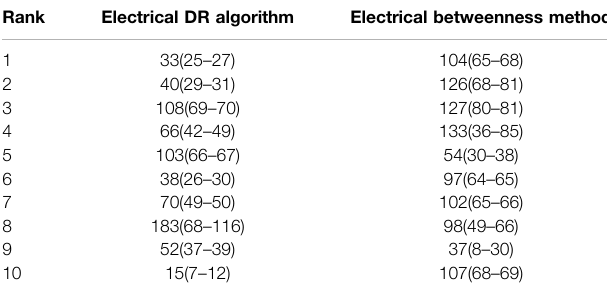
TABLE 4 | R l values of the IEEE-118 network are compared with those of the electrical betweenness method.